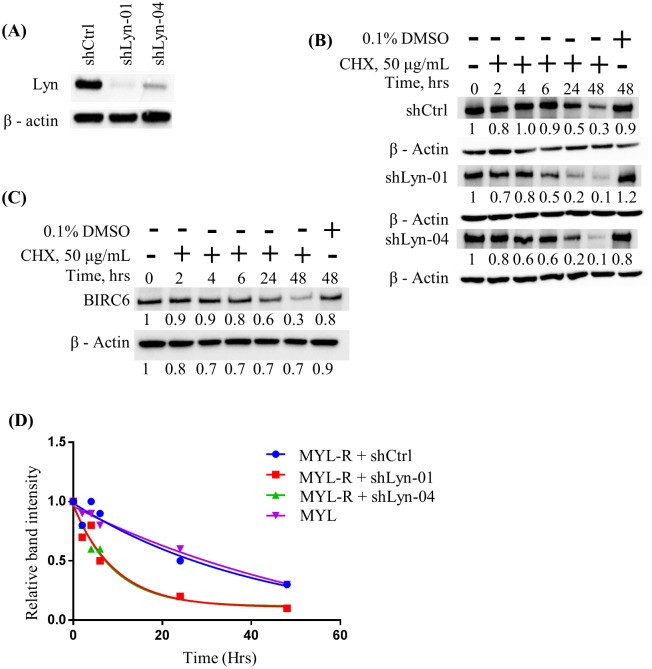
Lyn knockdown reduced the half-life of BIRC6 protein in MYL-R cells.(A) MYL-R cells were infected with lentiviral particles containing anti-Lyn shRNA constructs (shLyn-01 and -04), and Lyn knockdown confirmed by immunoblot analysis. (B) Lyn knockdown in MYL-R cells reduced the half-life of BIRC6 4-fold (~24 hrs in shCtrl cells to ~ 6 hrs in Lyn knockdown cells). Lyn knockdown MYL-R cells were incubated with 50 μg/mL cycloheximide (CHX) in a time-course manner and BIRC6 protein determined by immunoblotting. (C) BIRC6 half-life in MYL cells was ~24 hours. MYL cells were treated with CHX as in (B) and BIRC6 protein determined by immunoblotting. (D) GraphPad™ Prism was used to plot change in BIRC6 stability over time upon Lyn-knockdown in MYL-R cells as described in (B). The BIRC6 stability data presented here are representative of two independent experiments.